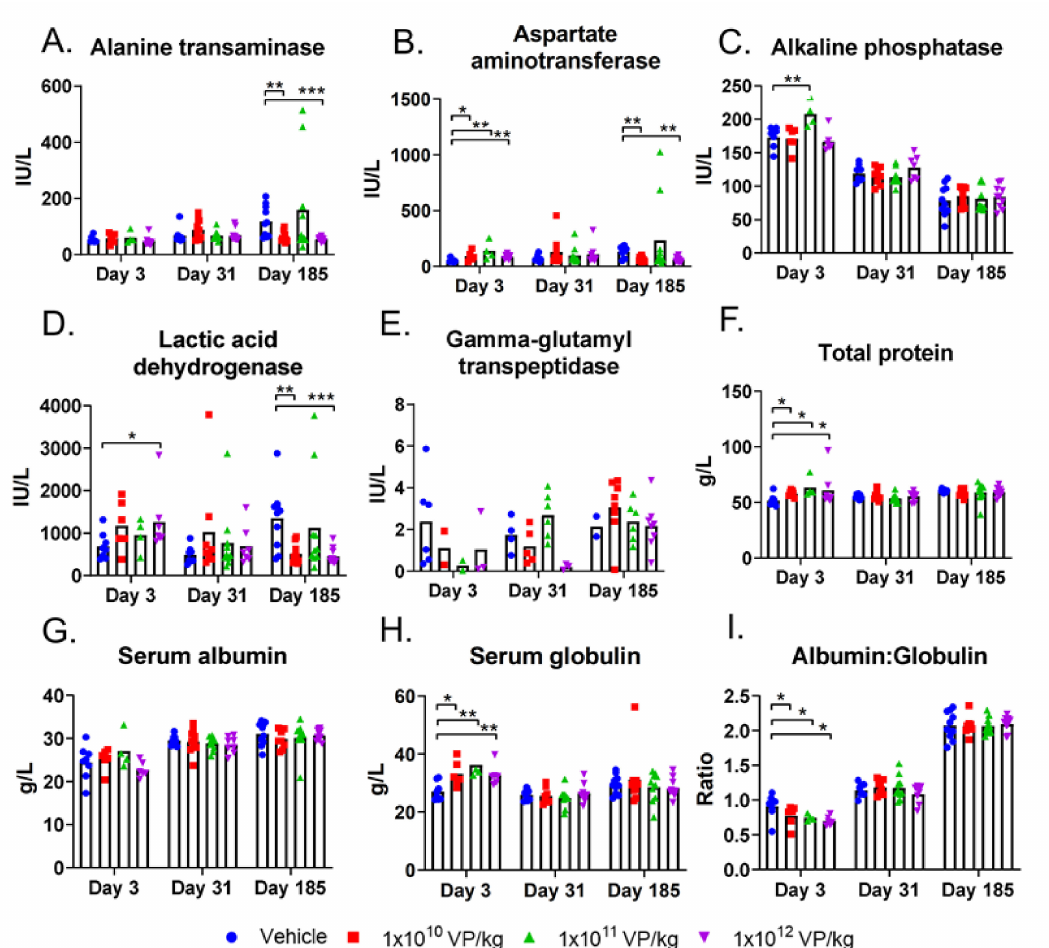
Figure 3. Blood chemistry values in hamsters: the hamsters received six i.p. TILT-123 injections at three different doses. Alanine transaminase ( A ), aspartate aminotransferase ( B ), alkaline phosphatase ( C ), lactic acid dehydrogenase ( D ), gamma- glutamyl transpeptidase ( E ), total protein level ( F ), serum albumin ( G ), and serum globulin ( H ) were measured from hamster serum samples at three time points (3, 31, and 185 days after the first treatment). In addition, albumin to globulin ratio was calculated to depict the relative amounts of these proteins in serum ( I ). The data show means plus standard error of mean. Statistical significance between the molecule levels in the control group vs. treatment group on each time point was evaluated with the Mann–Whitney test (* p < 0.05; ** p < 0.01; *** p <